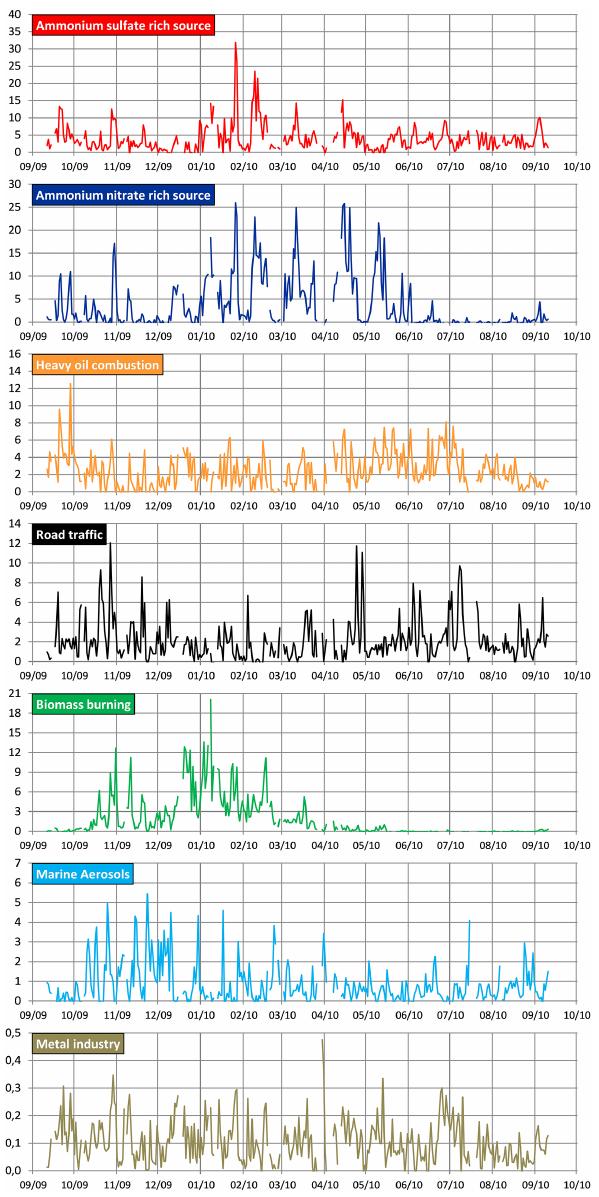
Figure 3. Daily contribution (µgm − 3 ) of each source to PM mass from 11 September 2009 to 10 September 2010. Note that results were taken from the base run exhibiting the lowest Q robust